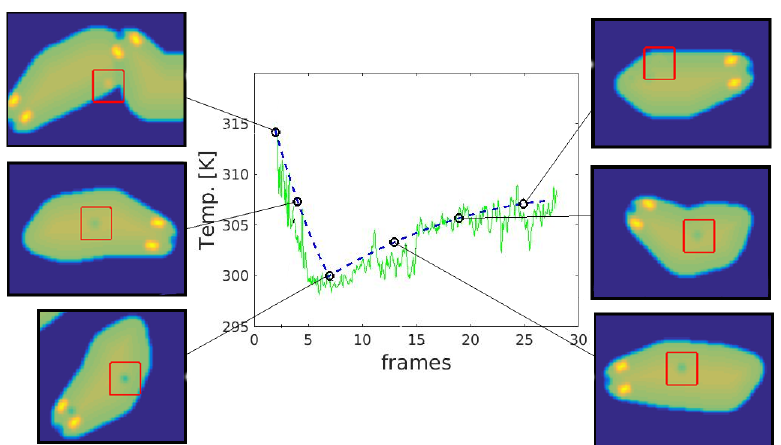
Figure 4. The plot of saliva temperature changes simulation (blue dashed line) and measurement (green line). Exemplary images for frames no 2, 4, and 7 show the visualization of traces during the cooling process. Frames no 13, 19, and 25 present the saliva in the heating process. Images demonstrate different